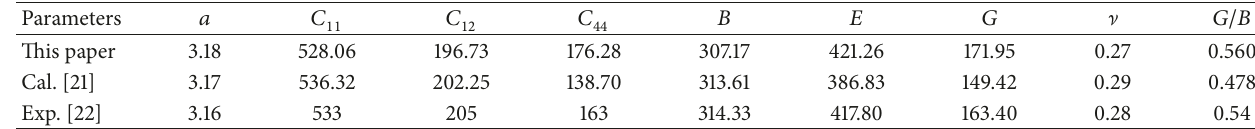
Table 1: Calculated and experimental lattice constants ( 𝑎 in ˚A), elastic constants ( 𝐶 𝑖𝑗 in GPa), bulk modulus ( 𝐵 in GPa), Young’s modulus ( 𝐸 in GPa), shear modulus ( 𝐺 in GPa), Poisson’s ratio ( ] ), and 𝐺/𝐵 for BCC W.